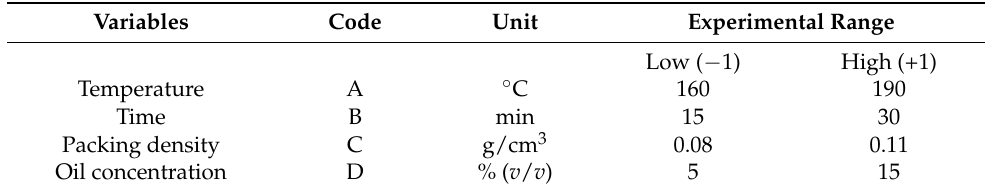
Table 1. Experimental values and levels of variables tested for EFB fibre as biosorbent in Plackett– Burman design.